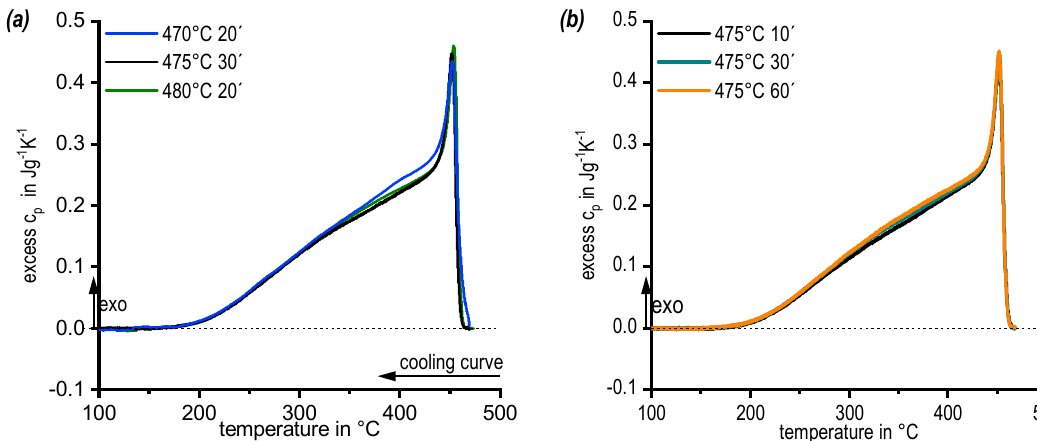
Figure 5. DSC cooling curves of alloy 7068 (cooling rate 0.01 K/s): ( a ) different solution annealing temperatures and ( b ) different solution annealing times.